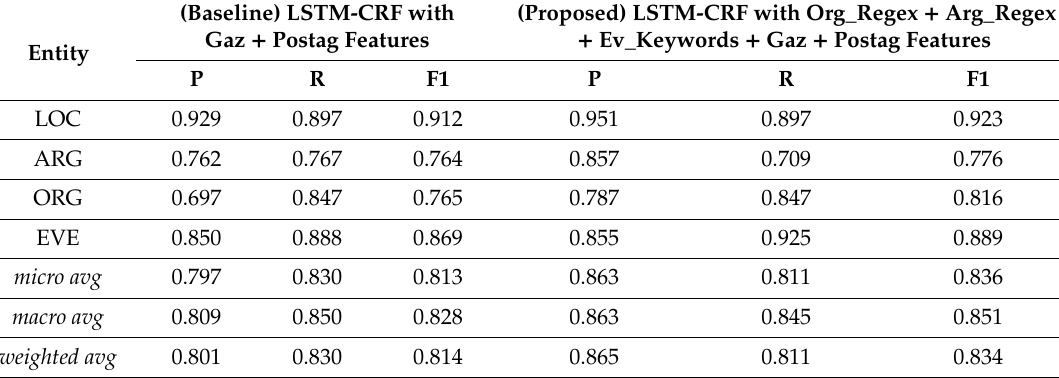
Table 6. Entity extraction performance (step 1).